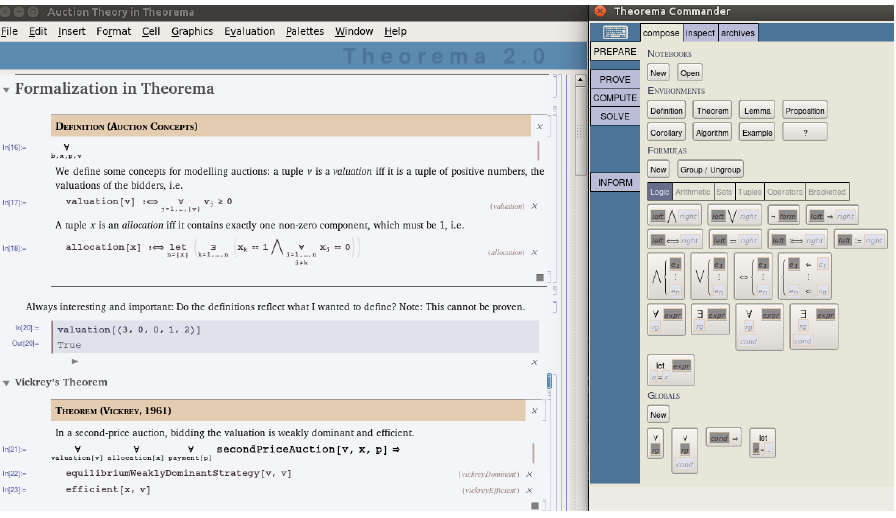
Fig. 1. Theorema 2.0 GUI: Content notebook left with Theorema commander to the